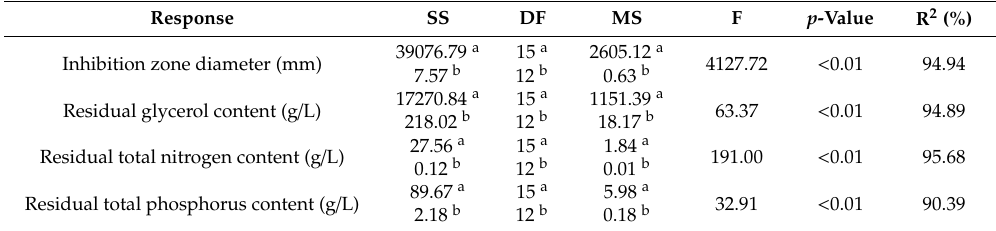
Table 2. ANOVA (analysis of variance) for the selected responses in the phase of modeling of medium composition for cultivation of B. velezensis IP22.